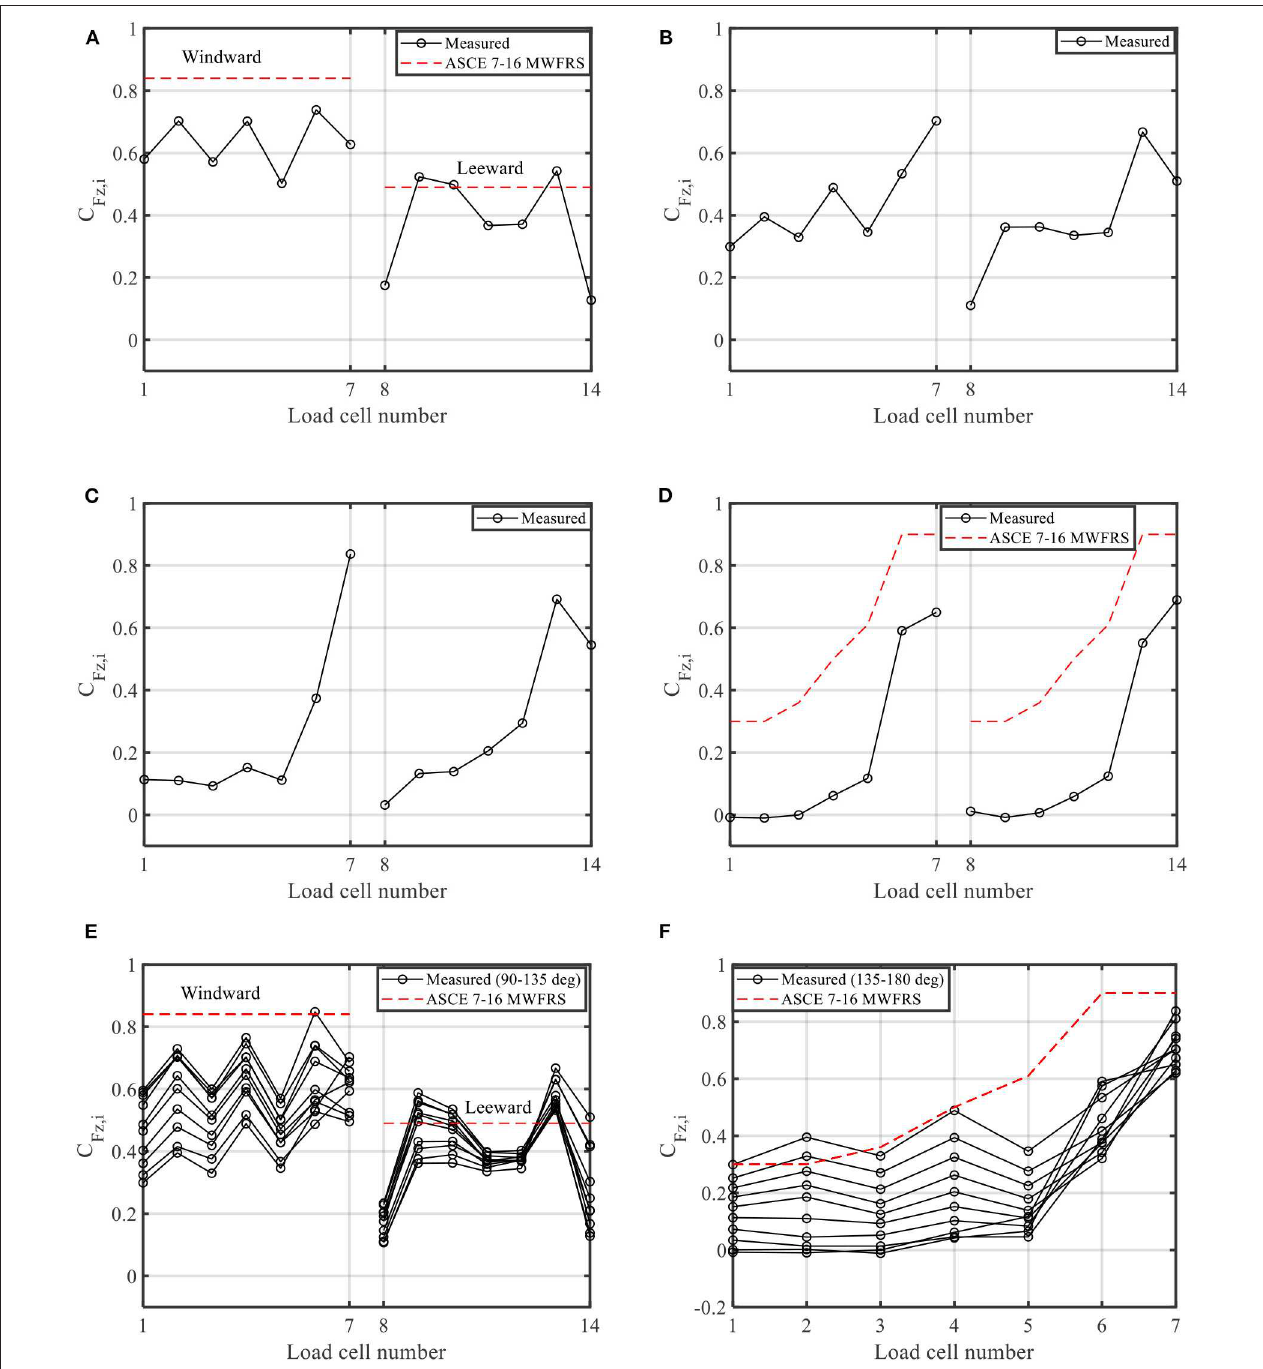
FIGURE 12 | Mean force coefficient distributions for enclosed building. (A) 90 ◦ wind angle, normal to ridge. (B) 135 ◦ wind angle. (C) 160 ◦ wind angle. (D) 180 ◦ wind angle, parallel to ridge. (E) Multiple wind angles (90–135 ◦ ). (F) Multiple wind angles (135–180 ◦ ).